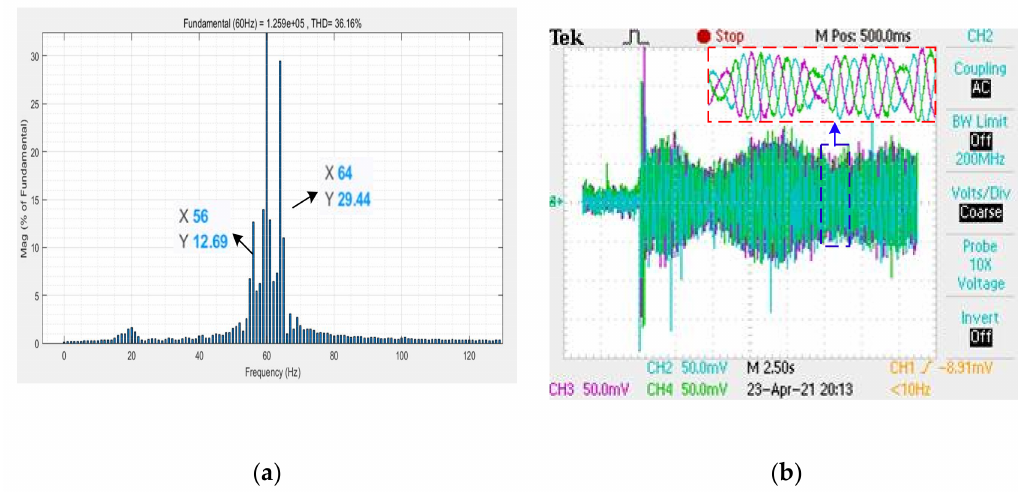
Figure 12. ( a ) Experimental waveforms of three-phase current and DC bus voltage at PCC under L g = 0.56 mH (SCR = 2); ( b ) THD of PCC current under L g = 0.56 mH (SCR =